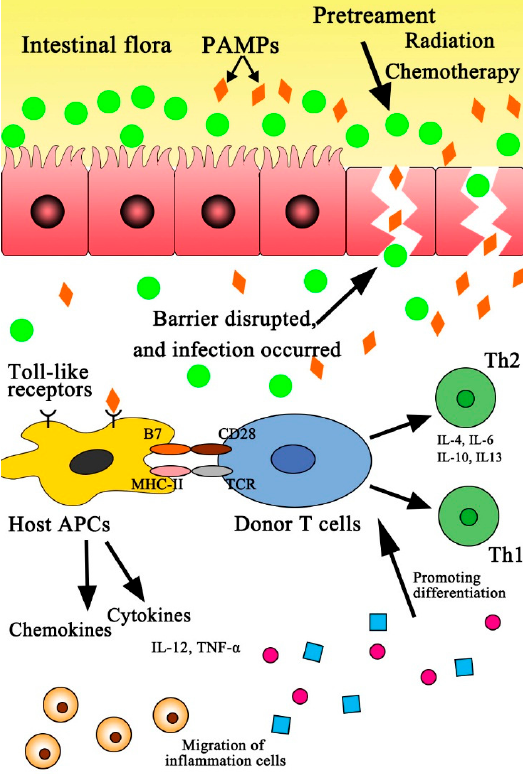
Figure 1. Schematic graph of GVHD initiated by intestinal flora. Intestinal flora enter the systemic circulation through damaged intestinal mucosa, and then interact with Toll-like receptors (TLRs), leading to the upregulation of major histocompatibility complex class II (MHCII) and costimulatory molecules B7 on host APCs. The upregulation of MHCII and costimulatory molecules B7 present the first and second activation signals, respectively, to donor T cells for the production of cytokines (including IL-1, IL-6, IL-12, IL-21, IL-22, IL-23, TNF- α and IFN- γ ). The cytokines then induce the differentiation of a sub-population of donor T cells (Th1/Th2). Subsequently, the activated donor-derived T cells attack target tissues or organs (including intestine, liver and skin) by direct cytotoxicity, and eventually leading to GVHD. PAMPs = pathogen-associated molecular patterns; APCs = antigen-presenting cells; Th1 = helper T cell 1; Th2 = helper T cell 2.